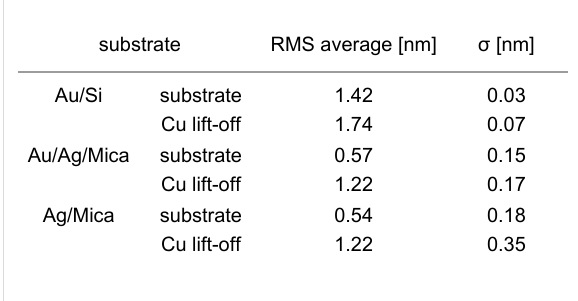
Table 1: Statistical analysis of the roughness measurements for different substrates and corresponding Cu surfaces after lift-off.